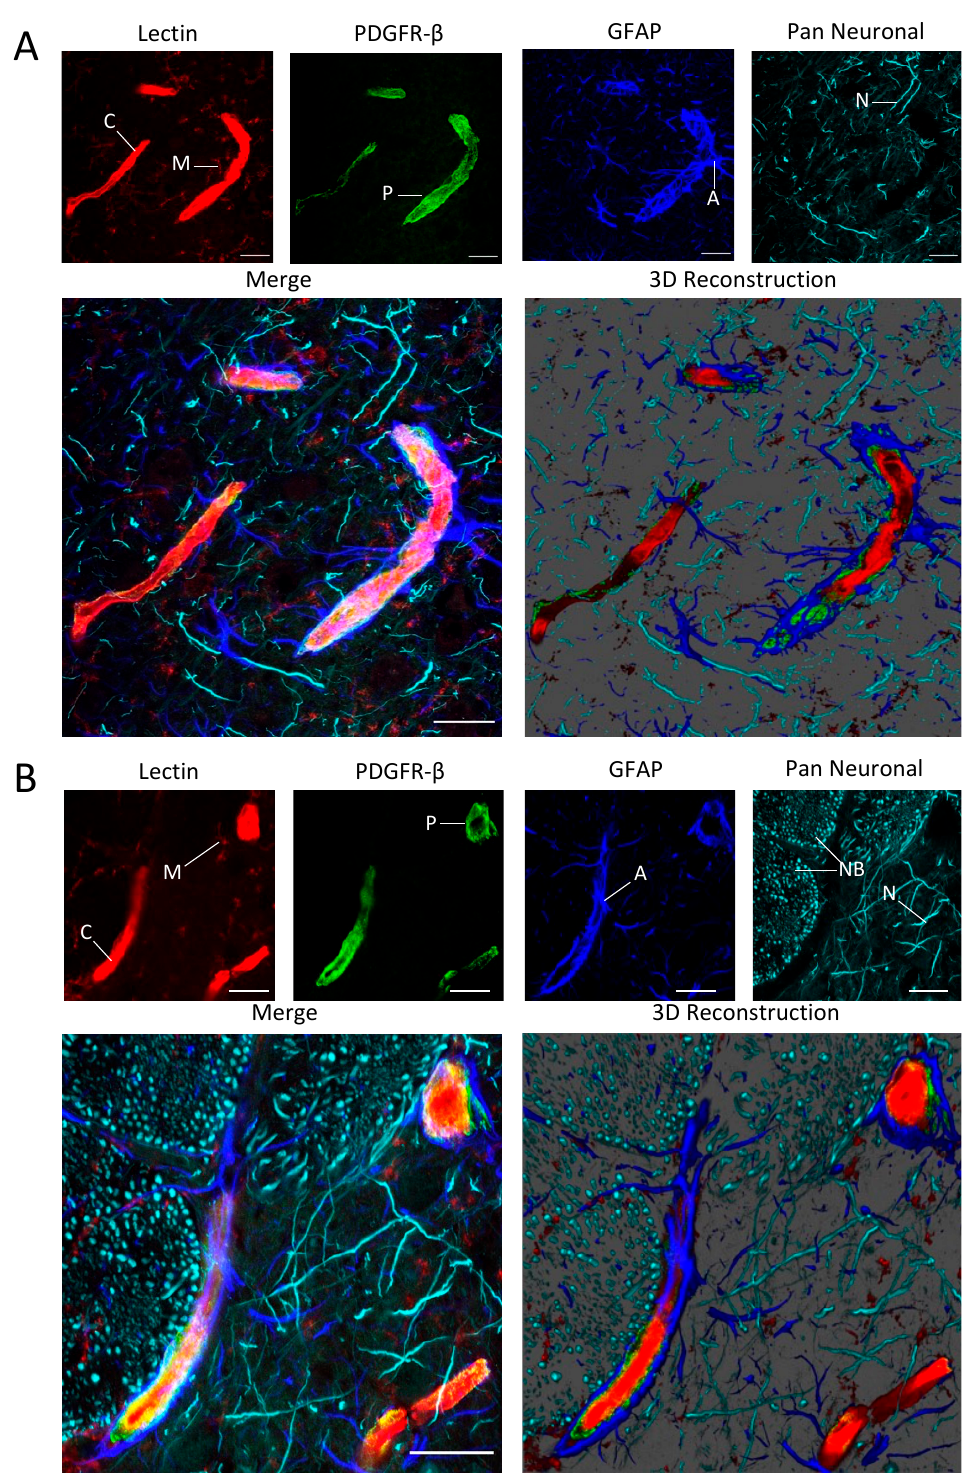
Figure 2. Images of regions in the cortex ( A ) and the caudoputamen ( B ) stained with the NVU labeling cocktail showing capillaries (C), microglia (M), pericytes (P), astrocytes (A), neurites (N), and nerve bundles (NB). Scale bar = 10 μ m.